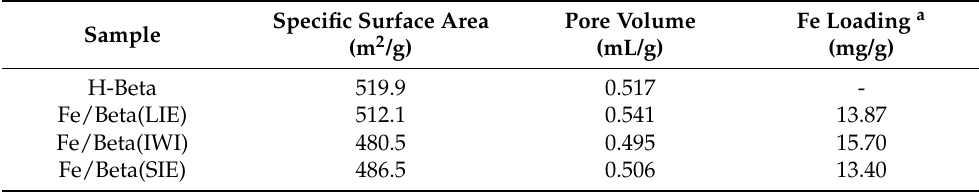
Figure 1. N 2 adsorption–desorption isotherms of H-Beta and Fe/Beta catalysts. Table 1. Properties of Fe/Beta catalysts prepared by different methods. LIE: liquid ion-exchange; IWI: incipient wet-impregnation; SIE: solid-state ion-exchange.